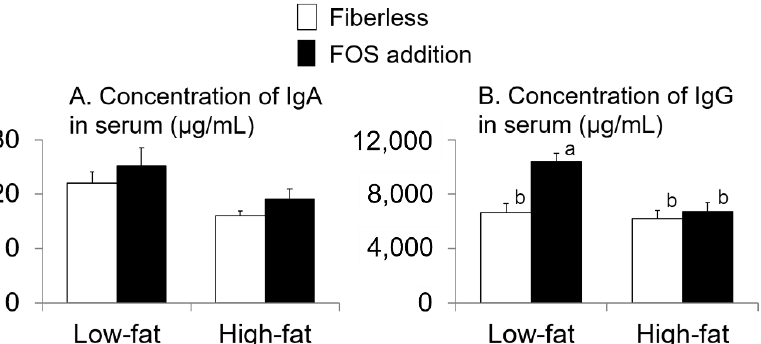
Figure 5. Effects of fat intake and fructo-oligosaccharide (FOS) supplementation on the concentra- of IgA ( A ) and immunoglobulin G (IgG) in serum ( B ). Values are Means ± SEM. n = 8 per group. two-way ANOVA. Values with different superscript letters are significantly different ( p < 0.05); Tukey’s multiple comparison.